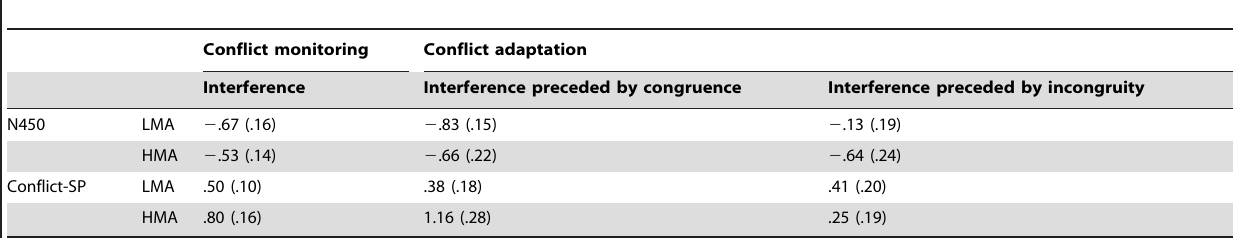
Table 3. Means and standard errors (in brackets) for N450 and Conflict-SP for conflict monitoring and conflict adaptation effects in the LMA and the HMA